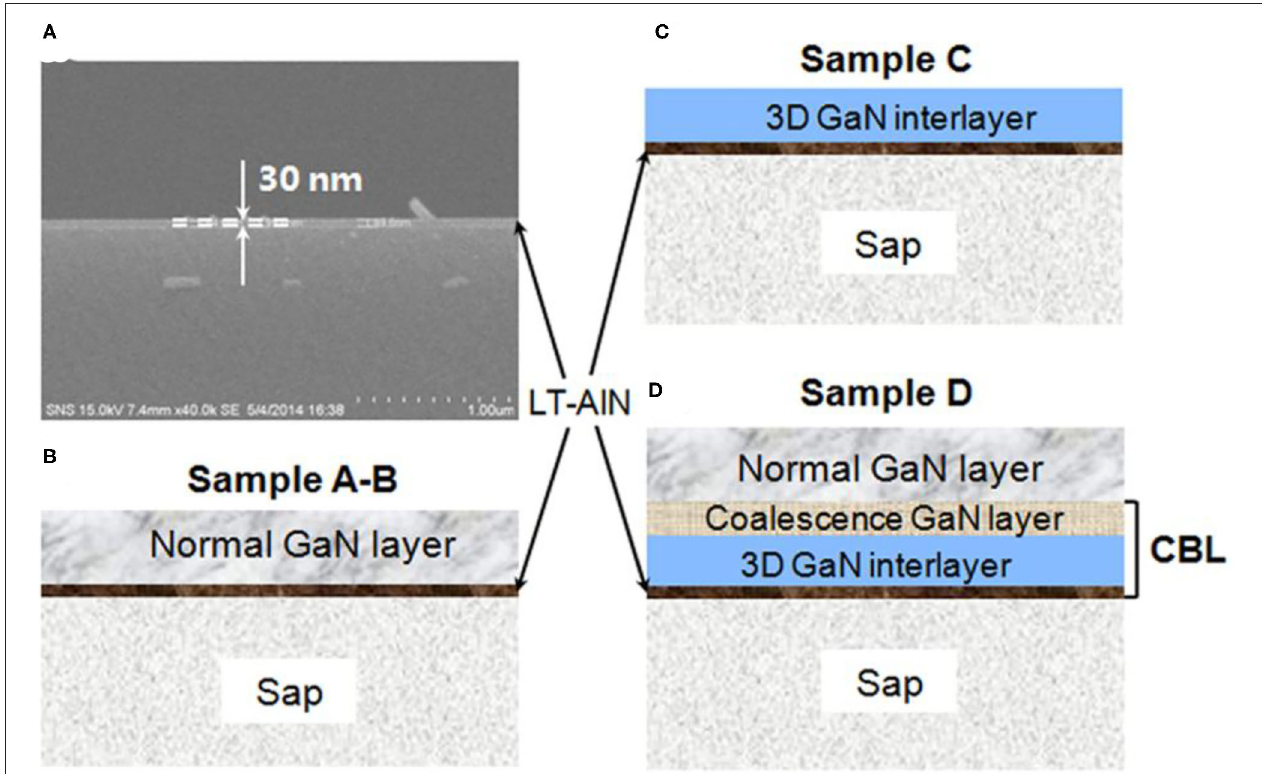
FIGURE 1 | (A) SEM image of a cross-section of a double-polished sapphire covered with LT-AlN. (B–D) Schematic diagrams of the processes designed for GaN